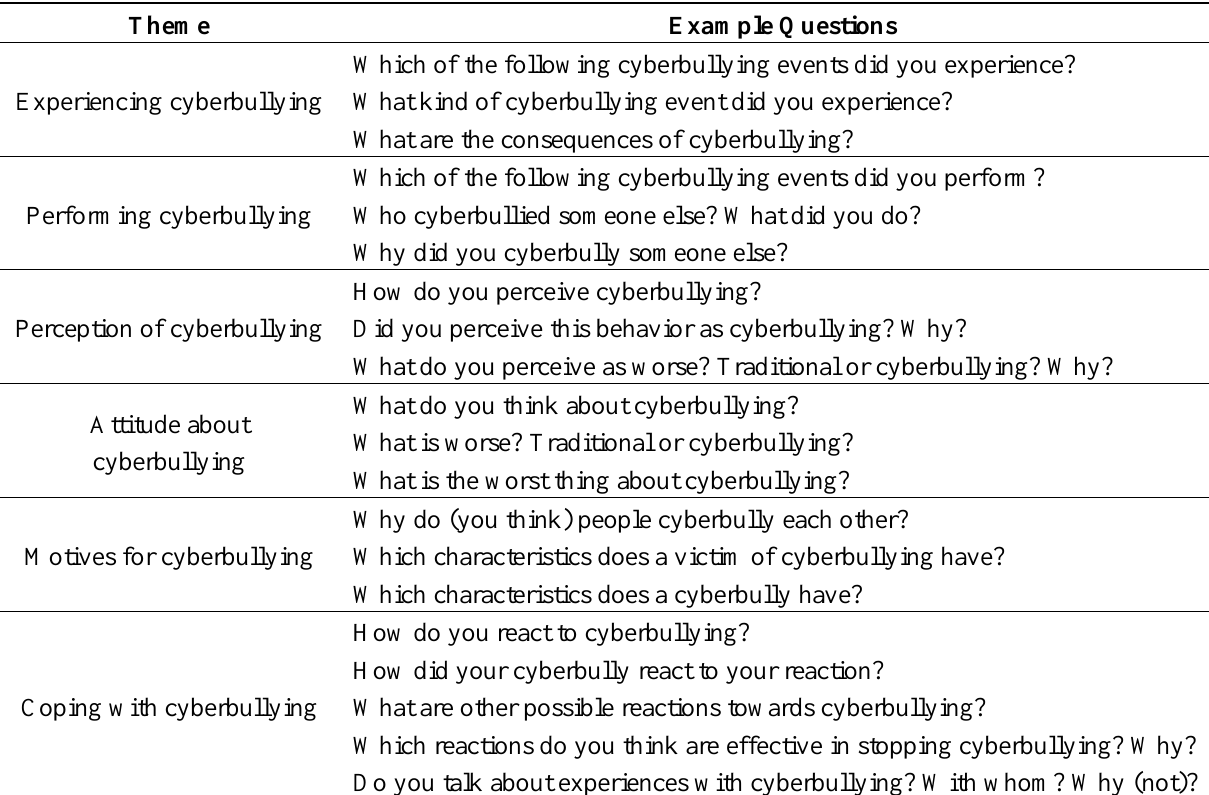
Table 1. Interview schedule with predefined